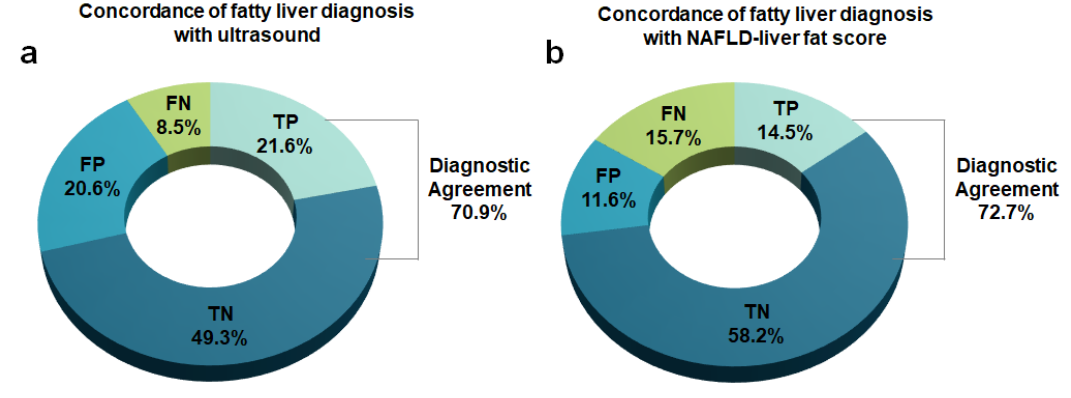
Figure 4. Concordance of fatty liver diagnosis with ultrasound ( a ) and non-alcoholic fatty liver disease liver fat score ( b ) in comparison with magnetic resonance imaging. TP: true-positive; TN: true-negative; FP: false-positive; and FN: false-negative.